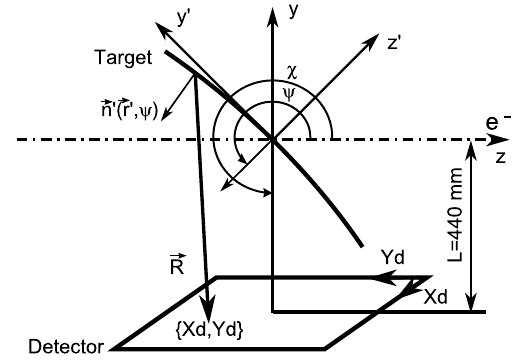
FIG. 1. The simulation scheme and some